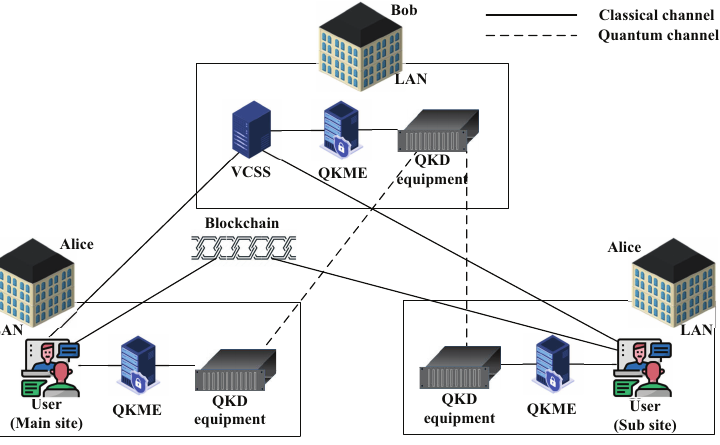
Figure 3. Scheme